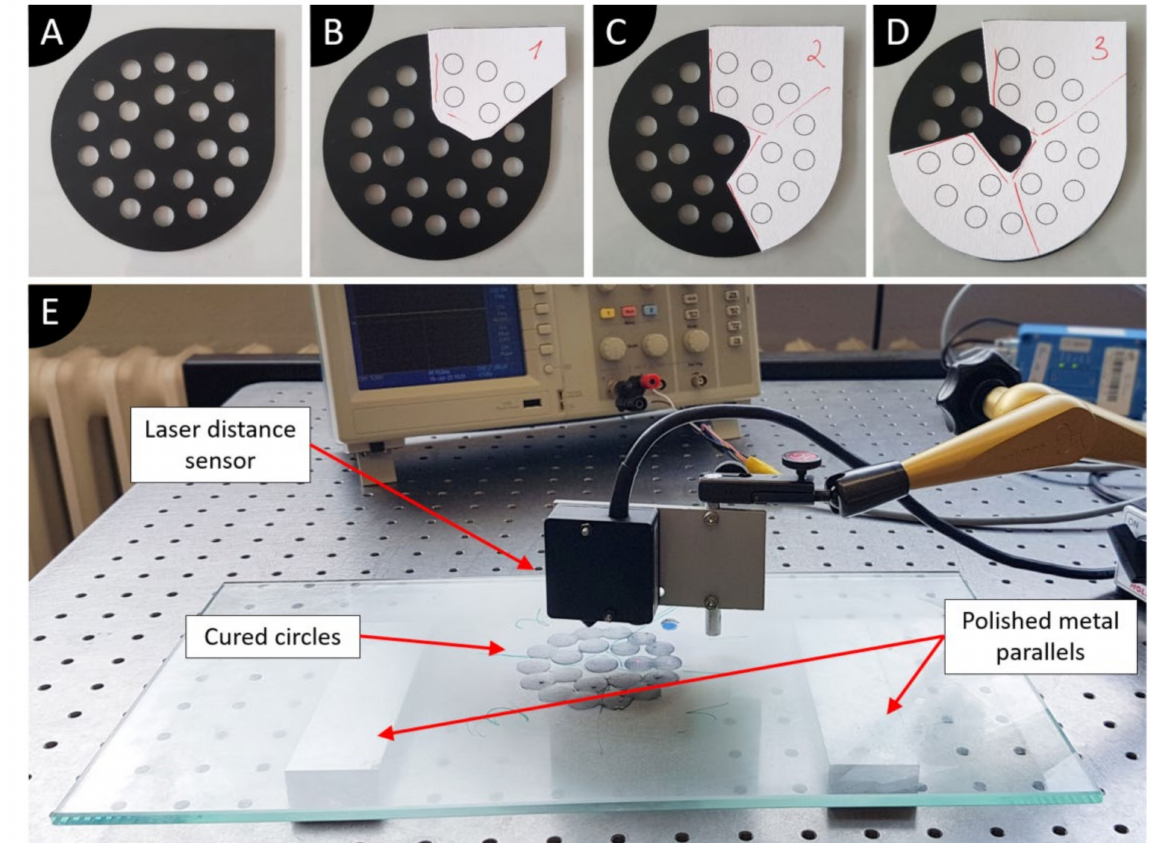
Figure 4. Masks used for cure depth specimen preparation and cure depth measurement setup: ( A ) t = 0, no additional mask; ( B ) t = 2 min, mask number 1; ( C ) t = 4 min, mask number 2; ( D ) t = 6 min, mask number 3; ( E ) Cure depth measuring